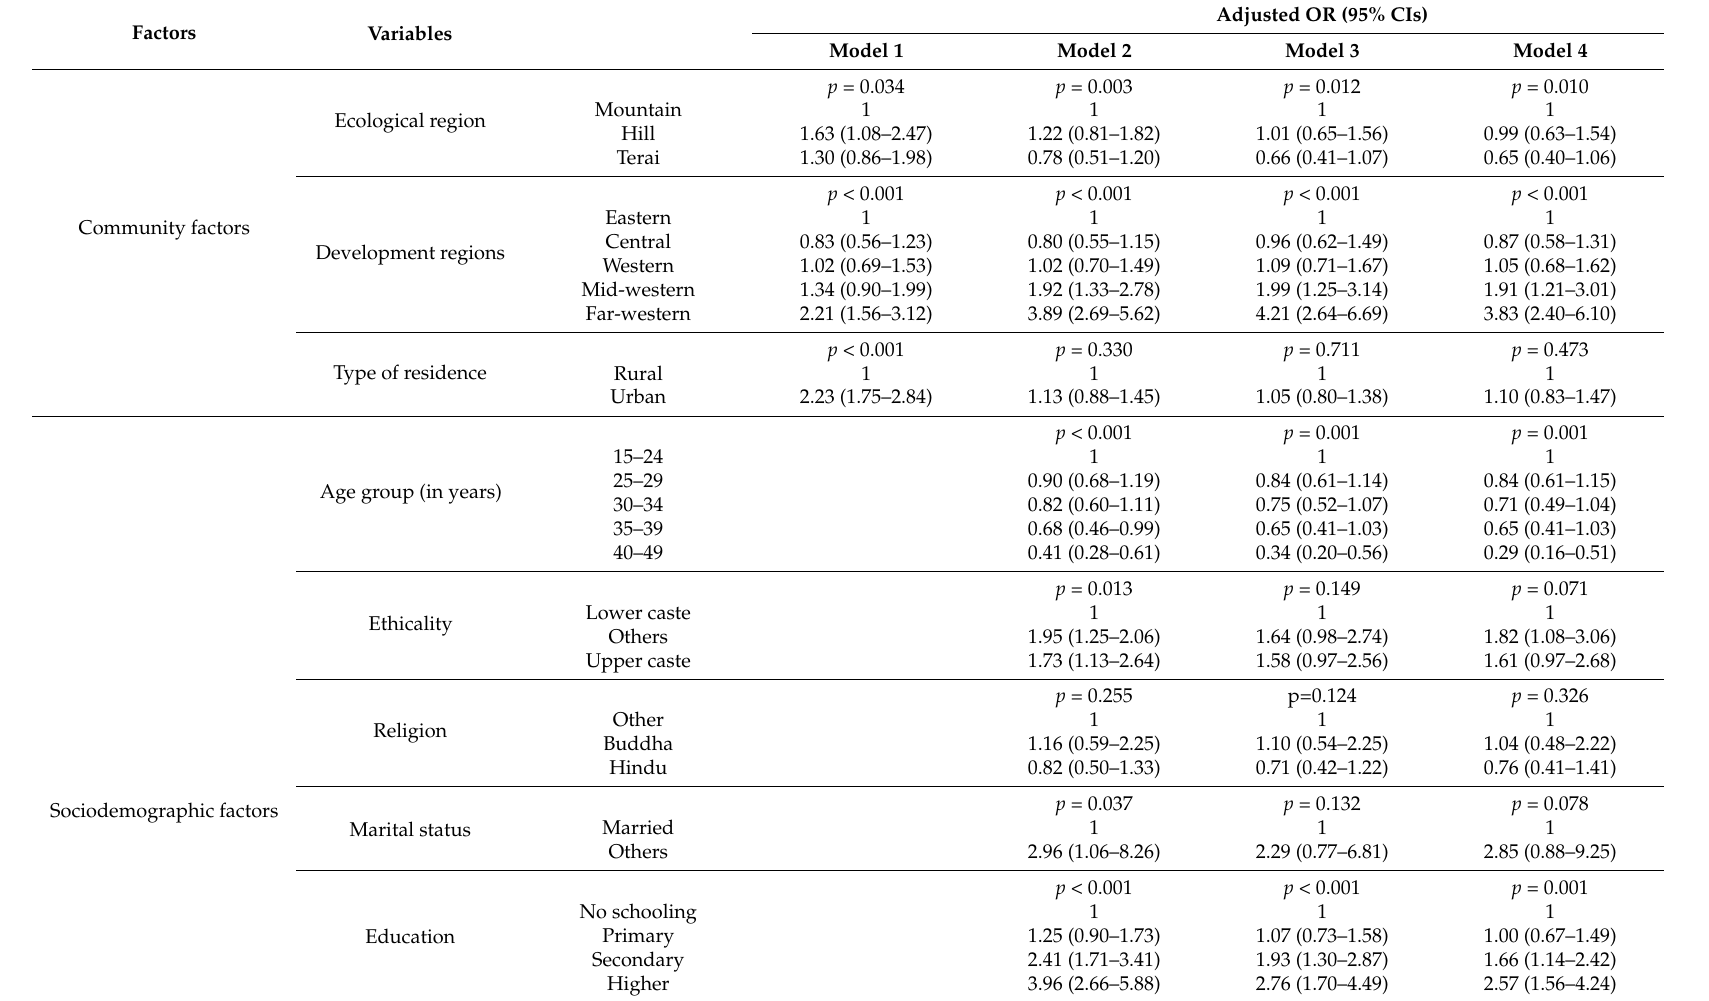
Table 4. Logistic Regression Analysis of Factors Associated with Condom Use among